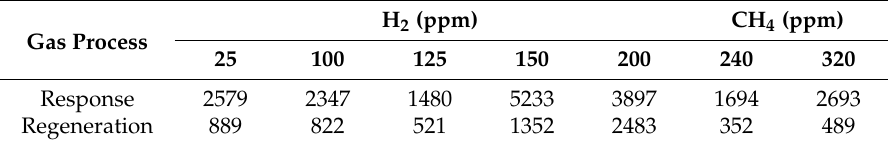
Table 1. Sensor response and regeneration for different H 2 and CH 4 concentrations.